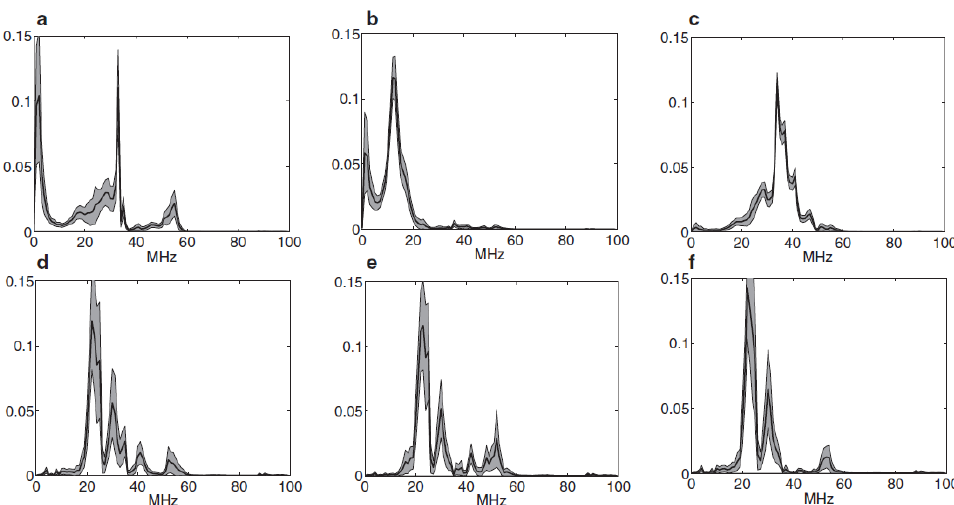
Figure 4. Average power spectral densities represented by a thick line. The shade corresponds to the area at one standard deviation of the mean. Left to right: (a), (d) measurements for corona, (b), (e) internal and (c), (f) surface discharges setups. The top row plots represent the normalized spectra of the partial discharges and the bottom plots are the normalized default modes in the three setups.